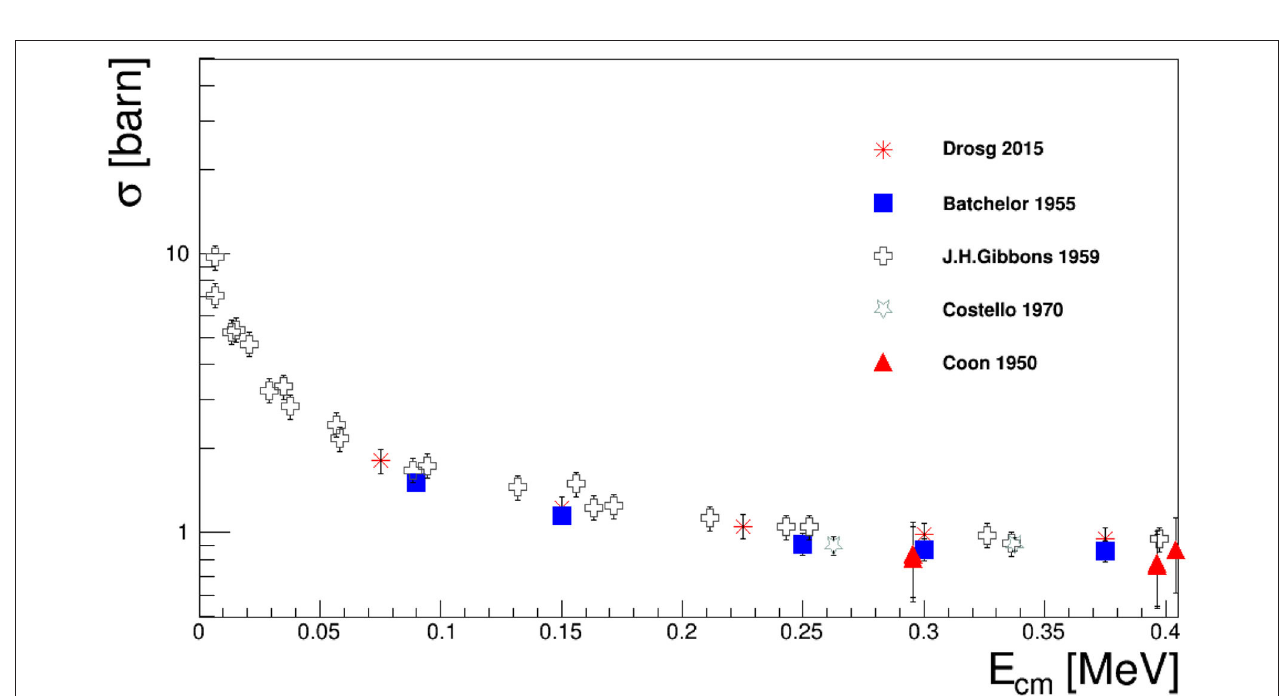
FIGURE 6 | Present day measurements of the 3 He(n,p) 3 H cross section performed by different methods as reported in the text.